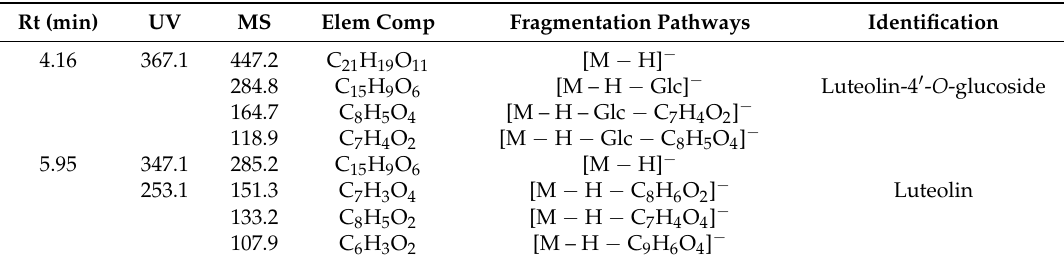
Table 2. Retention times (Rt), UV, MS data for identification of XOD inhibitors in G. hypoleucum by UPLC-MS.